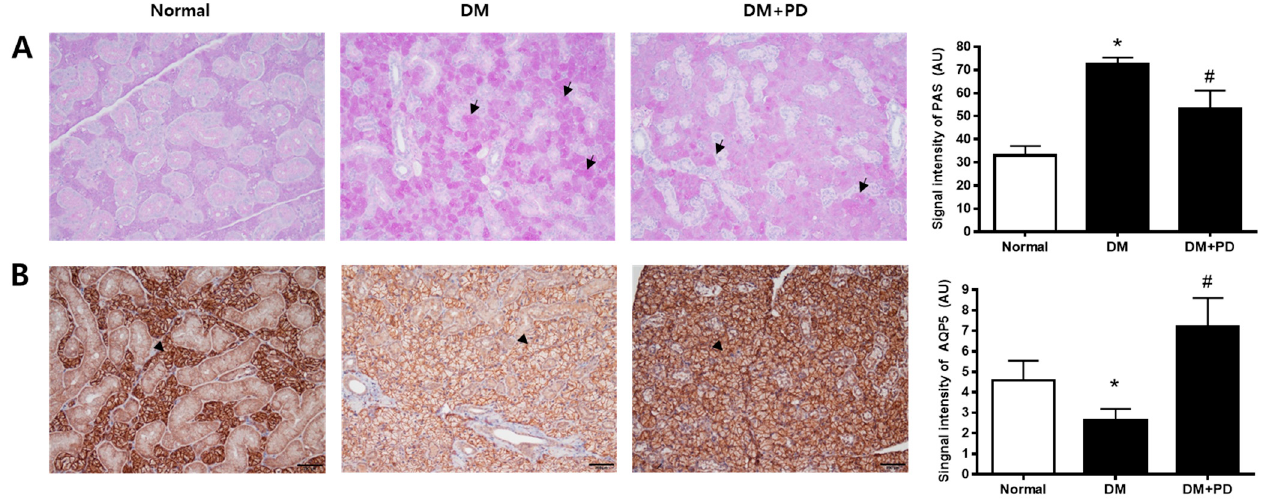
Figure 6. Effect of polydatin on mucin accumulation and AQP5 expression in submandibular glands. ( A ) Periodic acid-Schiff (PAS) staining of submandibular glands. Arrows indicate PAS positively stained cells. ( B ) Immunohistochemical staining for AQP5. Quantification of the AQP5 signal intensity. Arrowheads indicate AQP5 positively stained cells. Data are presented as the mean ± standard deviation ( n = 7). * p < 0.05 vs. Normal group; # p < 0.05 vs. DM group.